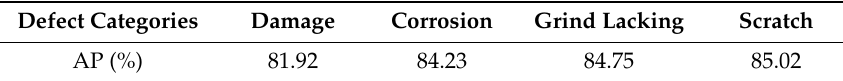
Table 6. AP of each defect category.